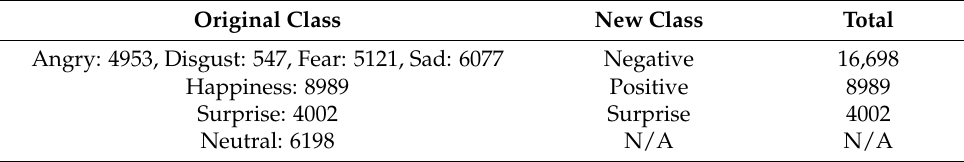
Table 2. Labels and number of samples in FER 2013 database.